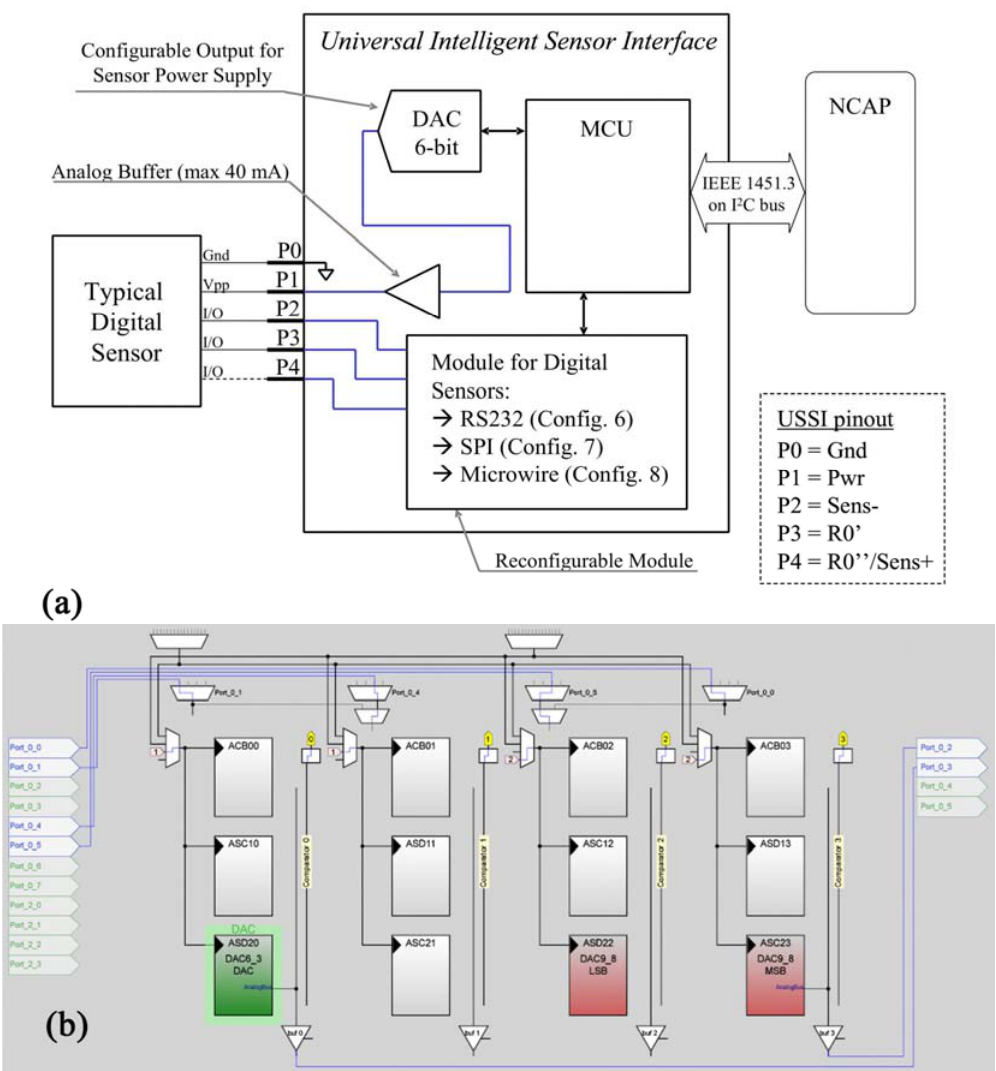
Figure 10. Digital sensors: (a) Logical scheme of UISI conditioning front-end and (b) screen-shot of related implementation in PSoC device through by means of Graphic